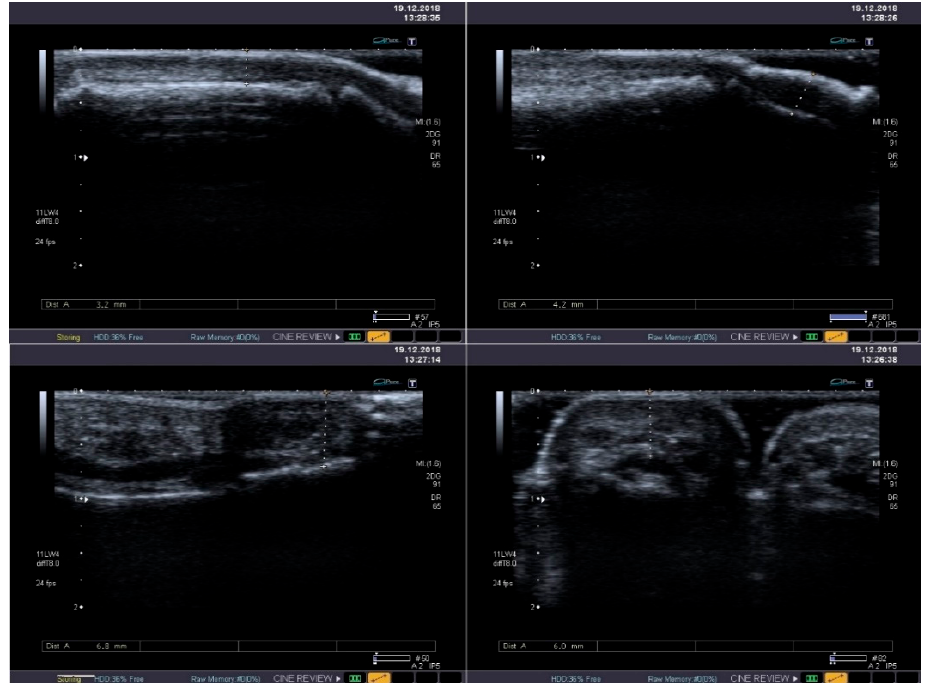
Figure 4. Standard B ‐ mode ultrasound reveals mild thickening and heterogeneous echogenicity of soft tissues with its fibrosis in the thumb ( upper panel) and in the second finger ( lower panel). Shear ‐ wave elastography (SWE) was recently proven as a useful method of quanti